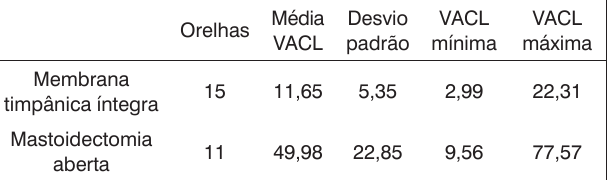
Tabela 4. Resultado das médias das quatro estimulações, calculadas pela fórmula de Jongkess, excluídos aqueles com estimulação paradoxal da prova calórica